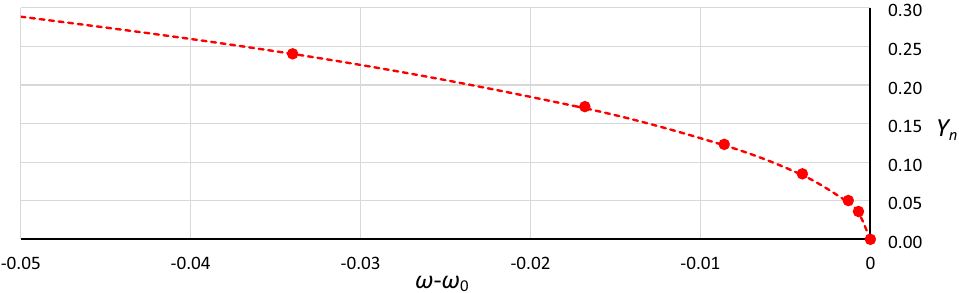
Figure 14. The consistency of the analytical (curve) and numerical (markers) approaches for case B2 ( α = 1.0000, β = − 0.045, ε = − 0.045) for small values of damping after using the modified procedure for determining the position of P B .